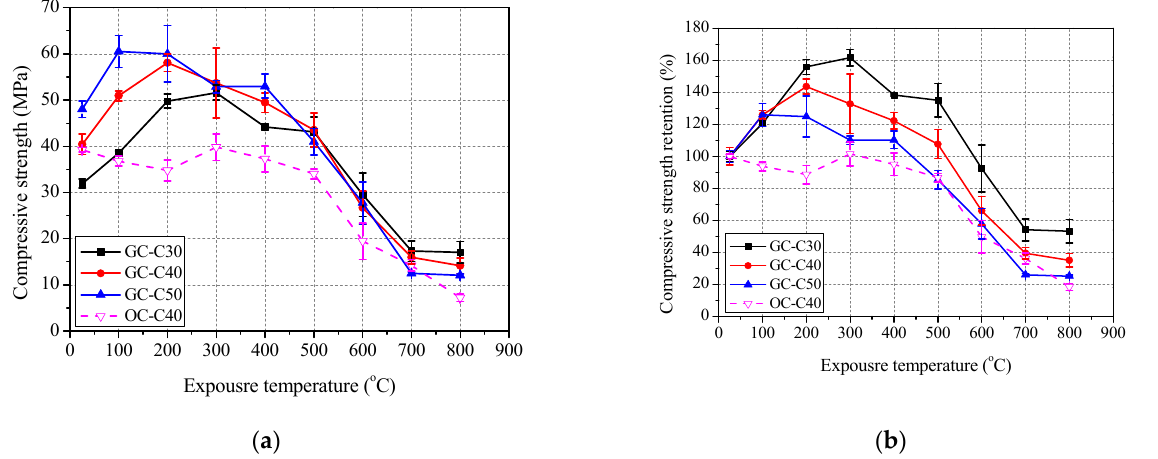
Figure 7. Residual compressive strength of concrete after exposure to elevated temperature: ( a ) compressive strength and ( b ) retention.